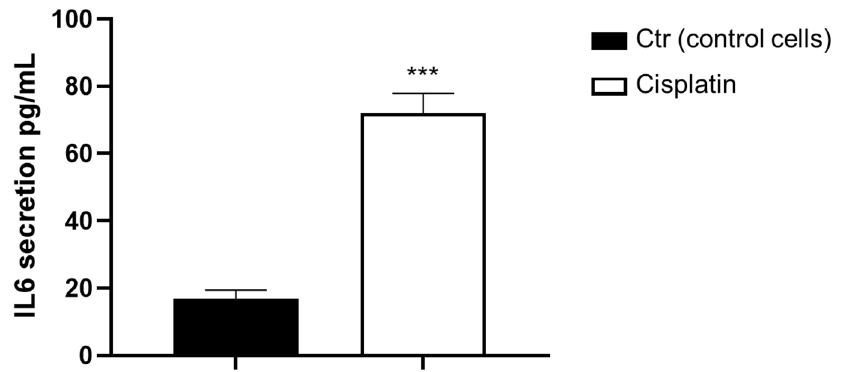
Figure 5. IL-6 secretion mediates STAT3 upregulation in GC cells. IL-6 levels in KATO III cells exposed to cisplatin for 48 h. The data are expressed as the means ± SD. The student’s t -test determined the significance: *** ( p < 0.001) represents significance compared to control.